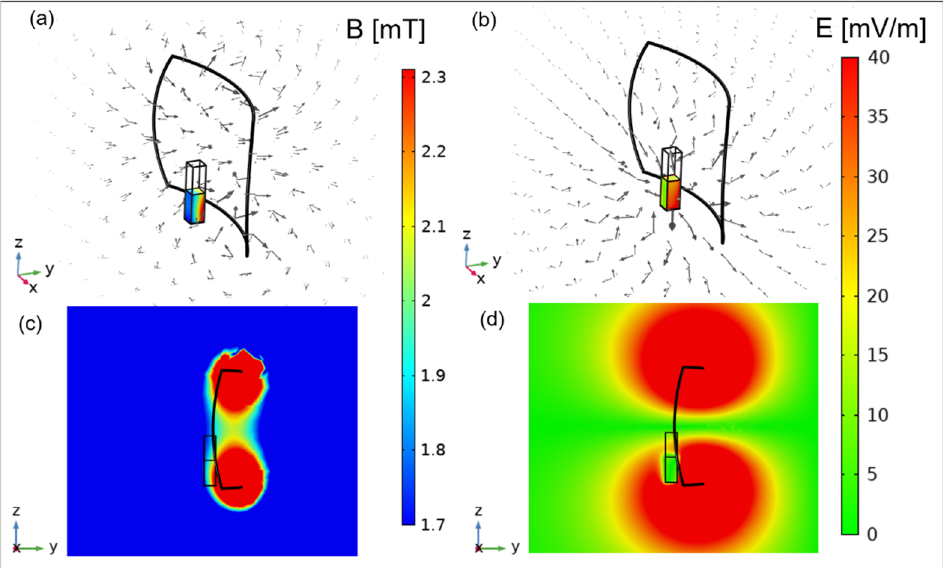
Figure 2. Simulation results of the exposure setup. ( a ) B field spatial distribution in the cuvette and B field arrows; ( b ) E field spatial distribution in the cuvette and E field arrows; ( c ) B field distribution on the central zy plane; ( d ) E field distribution on the central zy cut-plane.